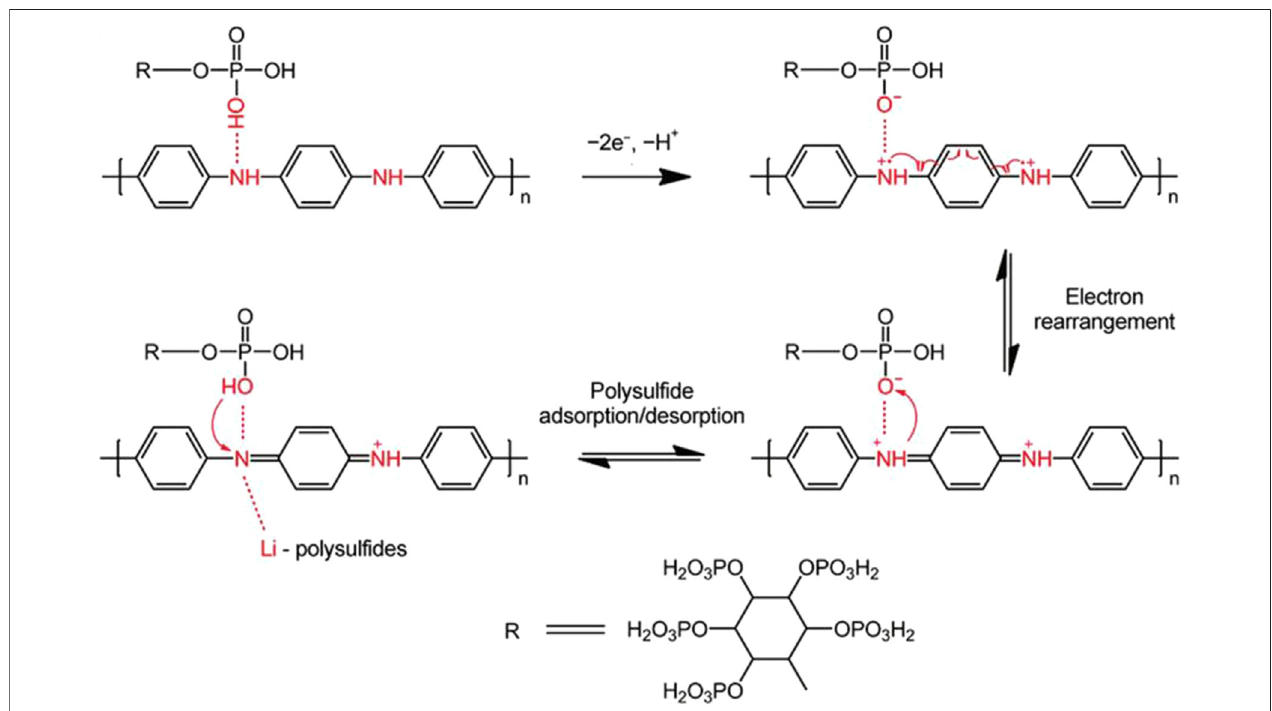
FIGURE 8 | Schematic illustration of the stabilization and enrichment of quinonoid imines by PA and their reversible transformations in Li − S batteries. Figure reproduced from the data in Chen C.-Y. et al. (2017).